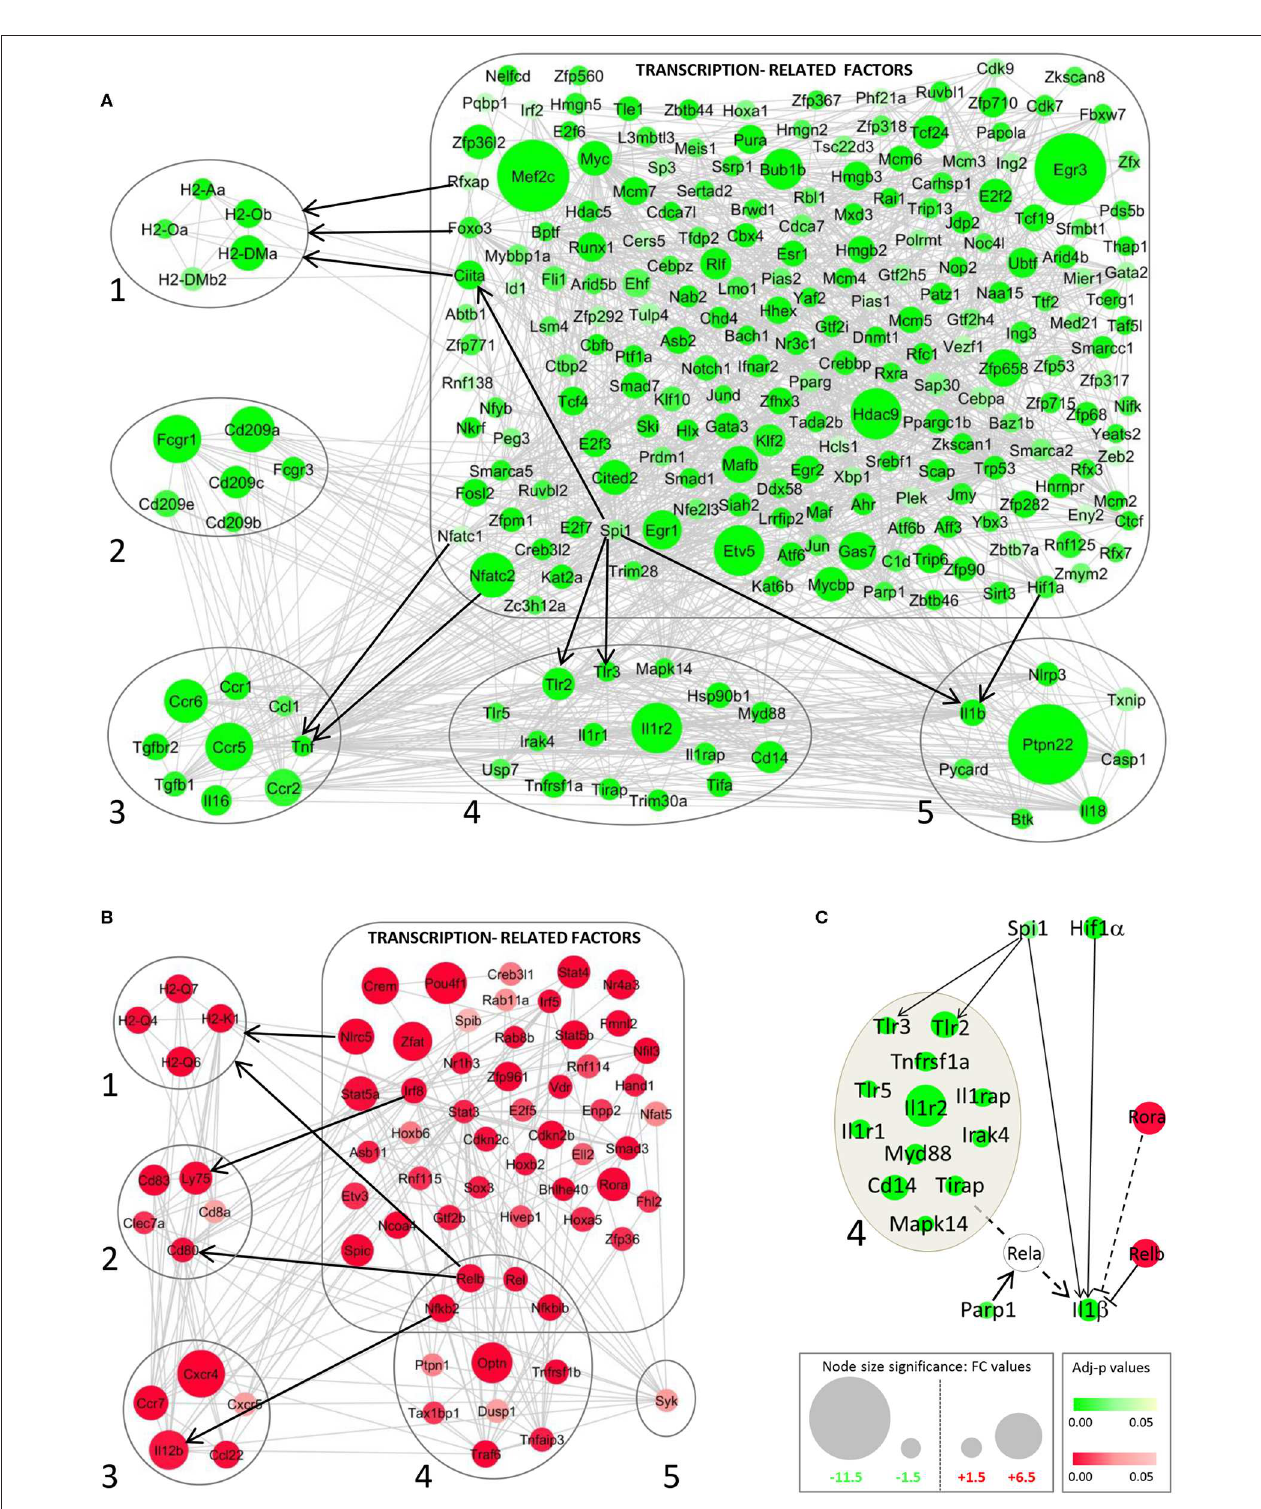
FIGURE 7 | STRING network analysis for modulated genes of transcription-related factors (TRFs) in DCs infected with Ab-opsonized amastigotes. Networks for down-modulated (green) (A) and up-modulated genes (red) (B) are shown. Interactions between TRFs and MHC II (1), DC markers/receptors (2), cytokine/chemokine receptors (3), TLR/Cytokine receptors and the NF- κ B pathway (4), and inflammasome-related molecules (5) are depicted. Gray lines correspond to active interactions (settings used for STRING analysis) and black arrows exemplify key TRF – target gene interactions validated by publication. (C) Integrative network of modulated TRFs and their related target genes involved in regulation of the IL-1 β gene. Dotted lines correspond to indirect interactions (mediated by RelA, related to the TLR/NF- κ B axis, group 4) on the IL-1 β gene.